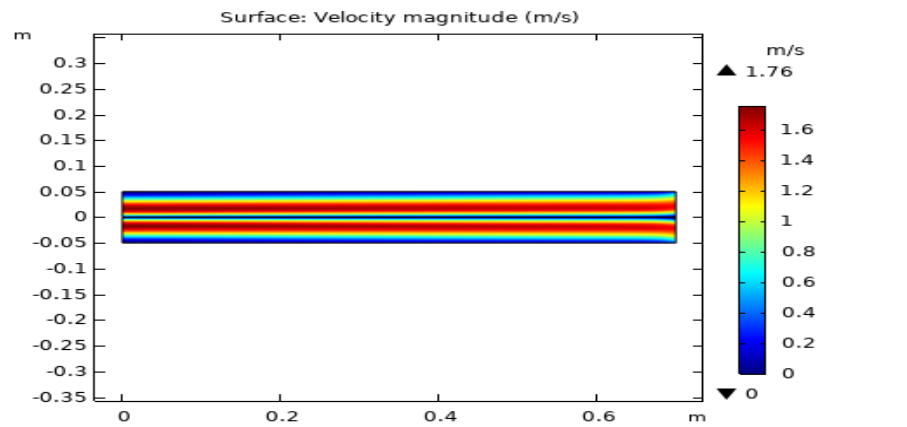
Figure 4: Velocity magnitude of the flow in the electrostatic